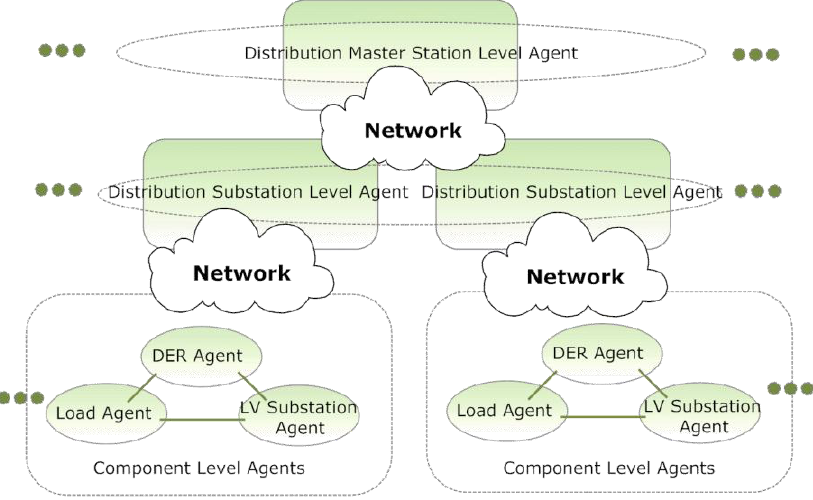
Figure 2. The relationship of different level agents in hierarchical